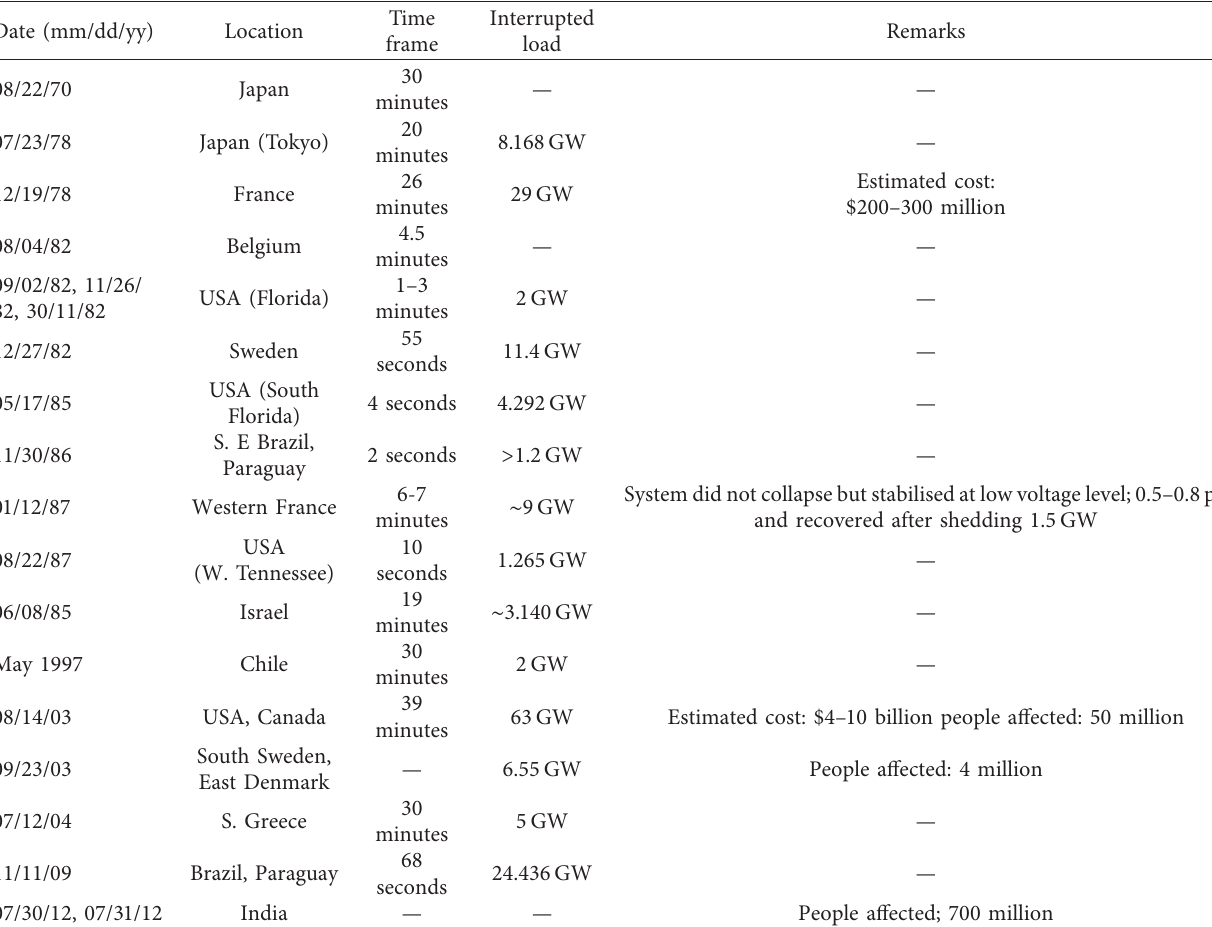
Table 1: Reported voltage collapse incidents over the years